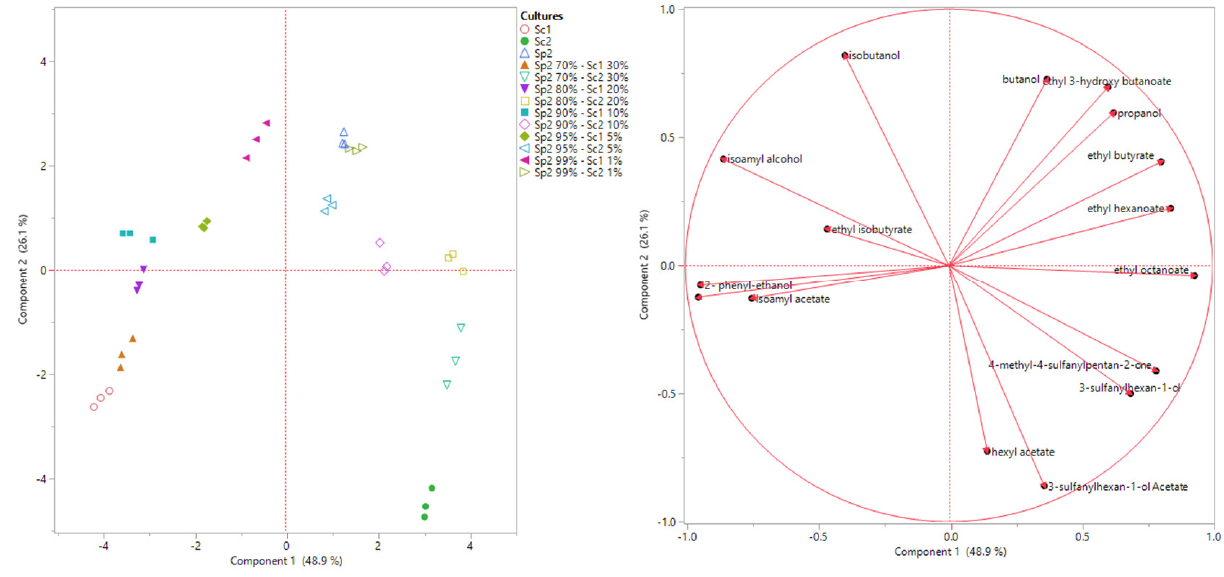
Figure 3. Principal component analysis of 39 volatile compounds analyses expressed as Odor Active Value (OAV) of Sauvignon blanc wines fermented with monocultures of S. cerevisiae and S. pastorianus (Sc1, Sc2 and Sp2) as well as with mixed cultures of both species in different inoculation ratios.